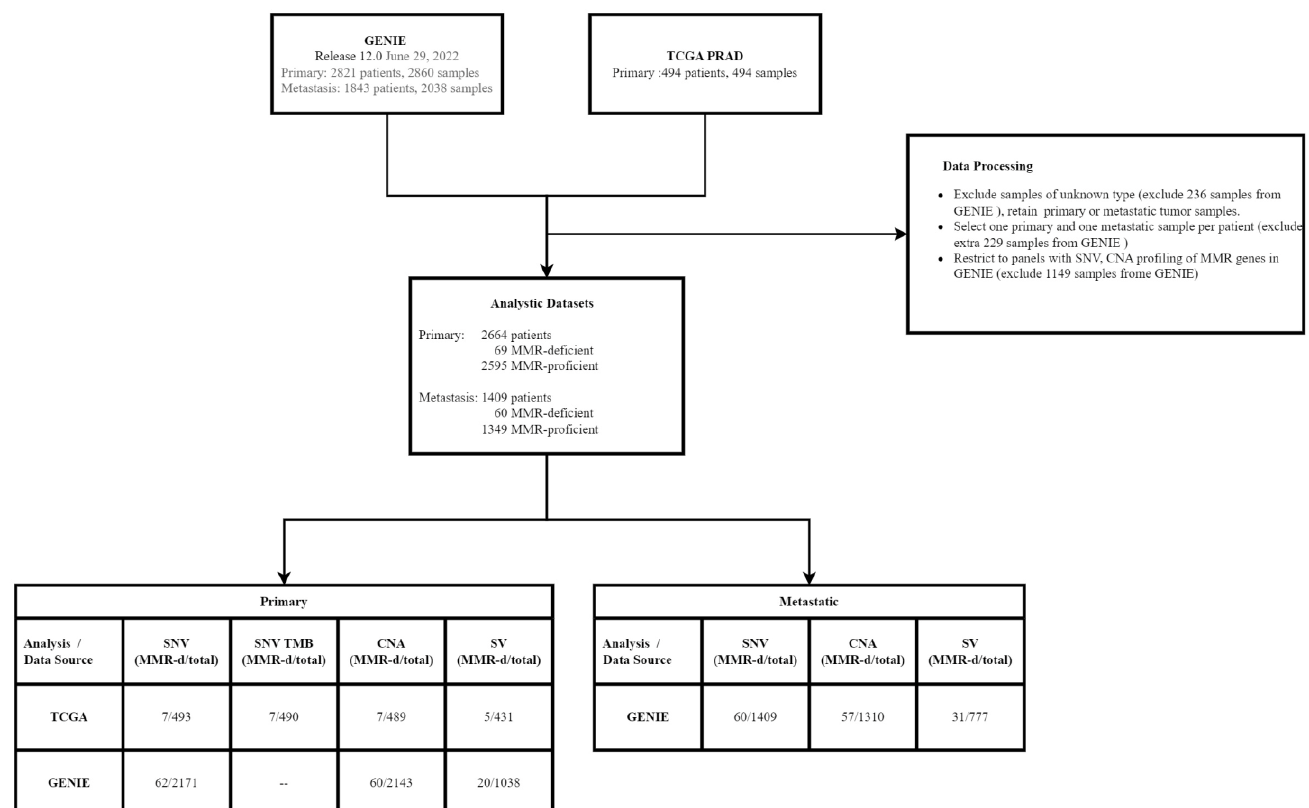
Figure 1. The workflow chart of the study. SNV = single nucleotide variant; TMB = tumor mutational burden; CNV = copy number variation; SV = structural variant; and MMR-d = mismatch repair-